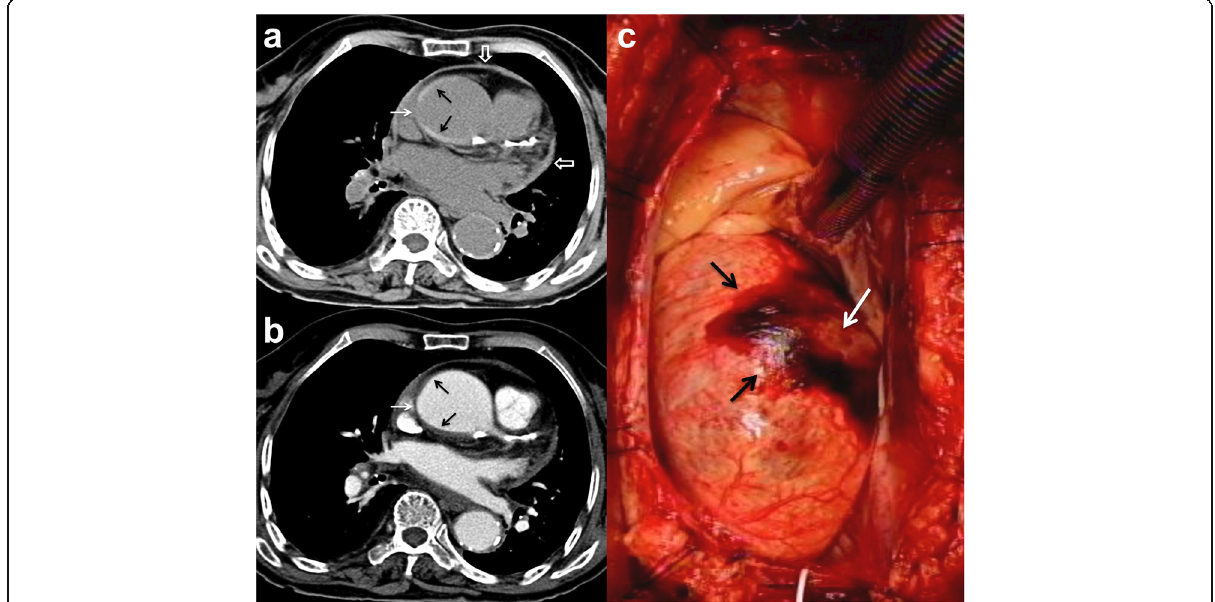
Fig. 4 a Unenhanced axial CT shows a smooth central defect (white arrow) in the hyper-attenuating crescentic hematoma (black arrows) along the ascending thoracic aorta and minimal hemopericardium. b Enhanced CT shows a smooth focal out-bulging (white arrow) of the aortic lumen corresponding to the defect on unenhanced study and non-enhancing crescentic hematoma (black arrows). Note the absence of intimal flap or contrast medium extravasation. c Surgical findings confirmed ecchymosis at the ascending aorta caused by IMH and focal